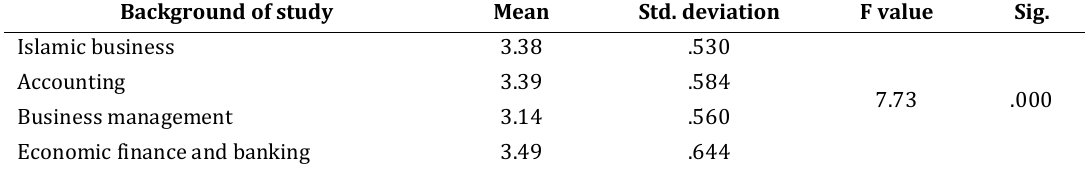
Table 6.The difference between background of study and awareness of Shariah-based PRS Background of study Mean Std. deviation F value Sig. Islamic business 3.38 Business management 3.14 .560 Economic finance and